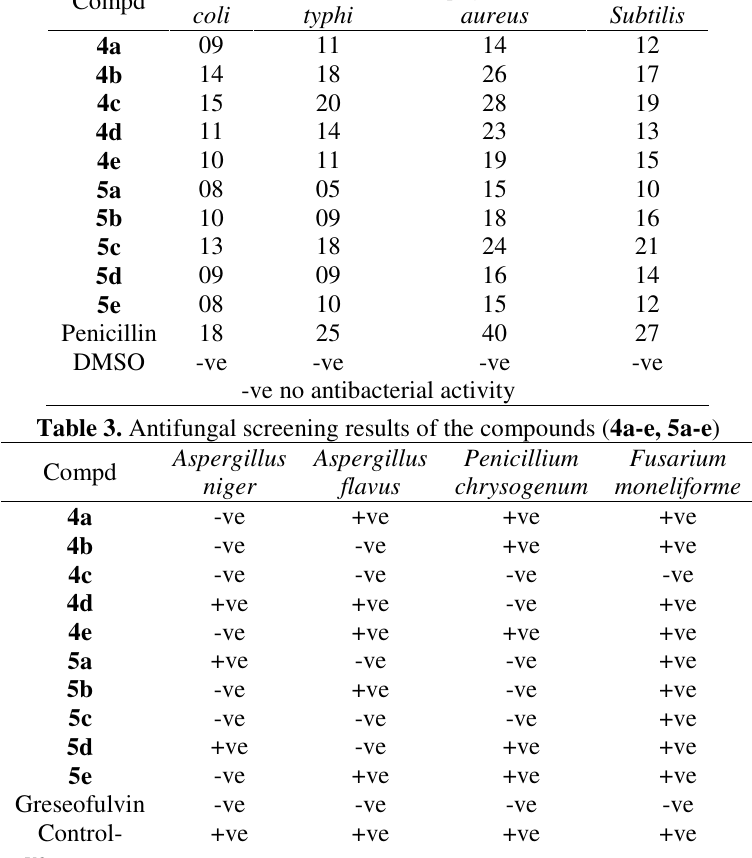
Table 2. Antibacterial screening results of the compounds ( 4a-e, 5a-e ).